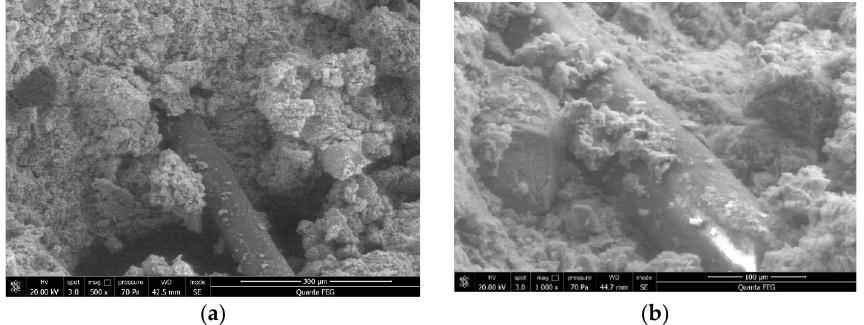
Figure 9. Microstructure of fracture surface after flexural strength test: ( a ) prior failed specimen; ( b ) optimum mixture design specimen.